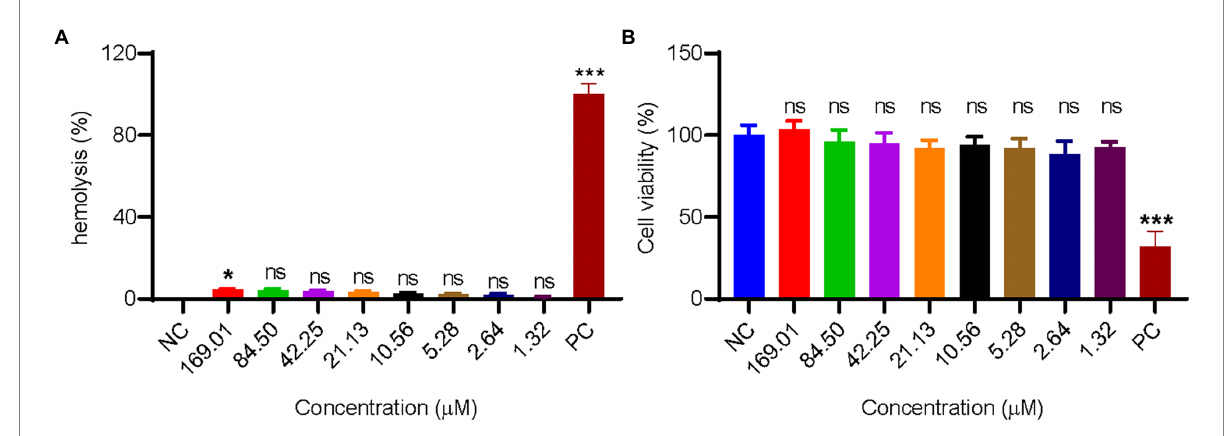
FIGURE 3 Hemolysis and cytotoxicity of GW18. (A) 100 μ l human mature red blood cell suspension was incubated with 100 μ l of GW18 at different concentrations (0–169.01 μ M). After incubation for 30 min at 37 ° C, cells were centrifuged (3,500 rpm, 5 min) and the absorbance of the supernatant was measured at 540 nm. The value for “zero hemolysis” was determined using sterile saline (negative control), while 100% hemolysis was established using 1% (v/v) Triton X-100 (PC: positive control). Hemolysis of testing sample was calculated as the percentage of Triton X-100- induced hemolysis. (B) HEK293T cells (1 × 10 5 cells) were plated into 96 well plates and incubated with GW18 (0–169.01 μ M) or 10% DMSO (PC: